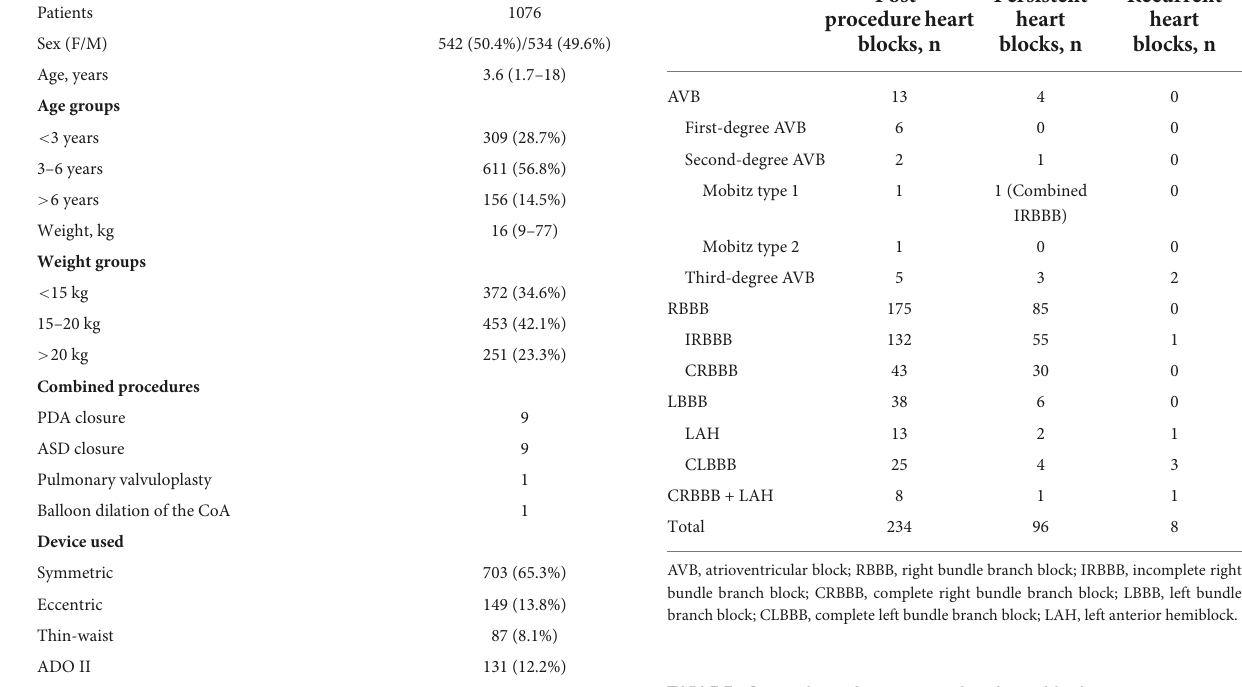
TABLE 3 Onset time of post-procedure heart